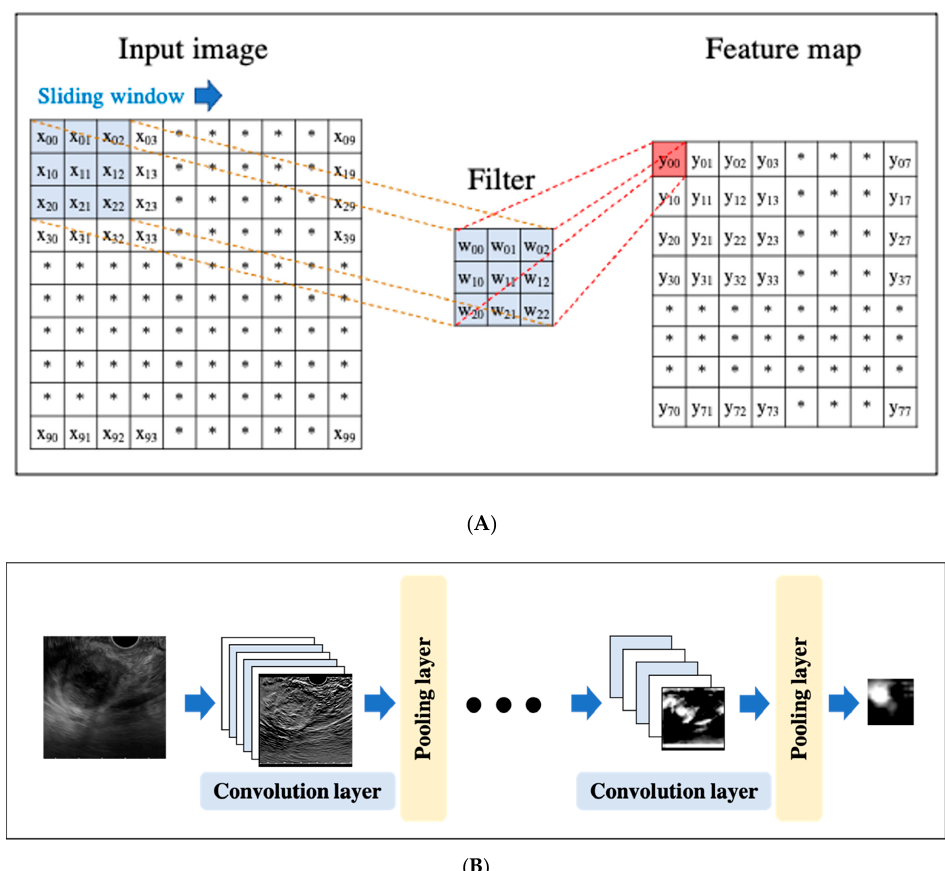
Figure 4. An example convolutional neural network (CNN). ( A ) Translation of an input image into a feature map in a convolution layer. ( B ) Layout of a deep convolutional neural network.